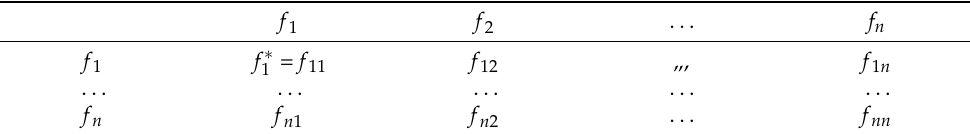
Table 1. Matrix of